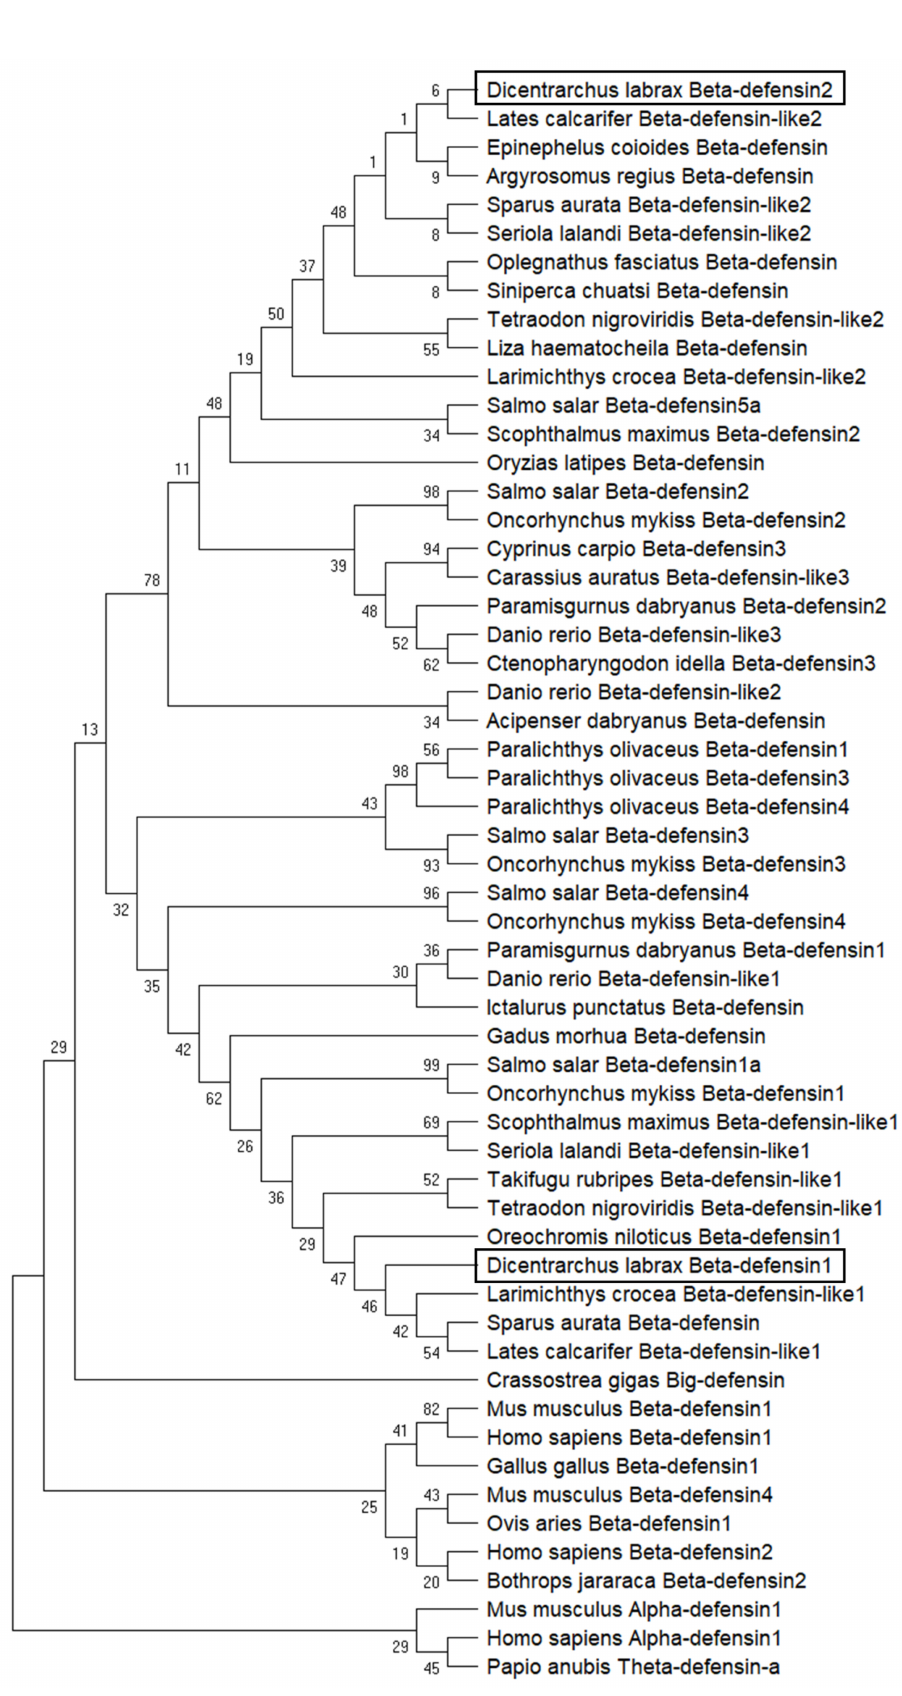
Figure 6. Phylogenetic analysis of beta-defensin peptides. The evolutionary history was inferred by using the Maximum Likelihood method and JTT matrix-based model [32]. The bootstrap consensus